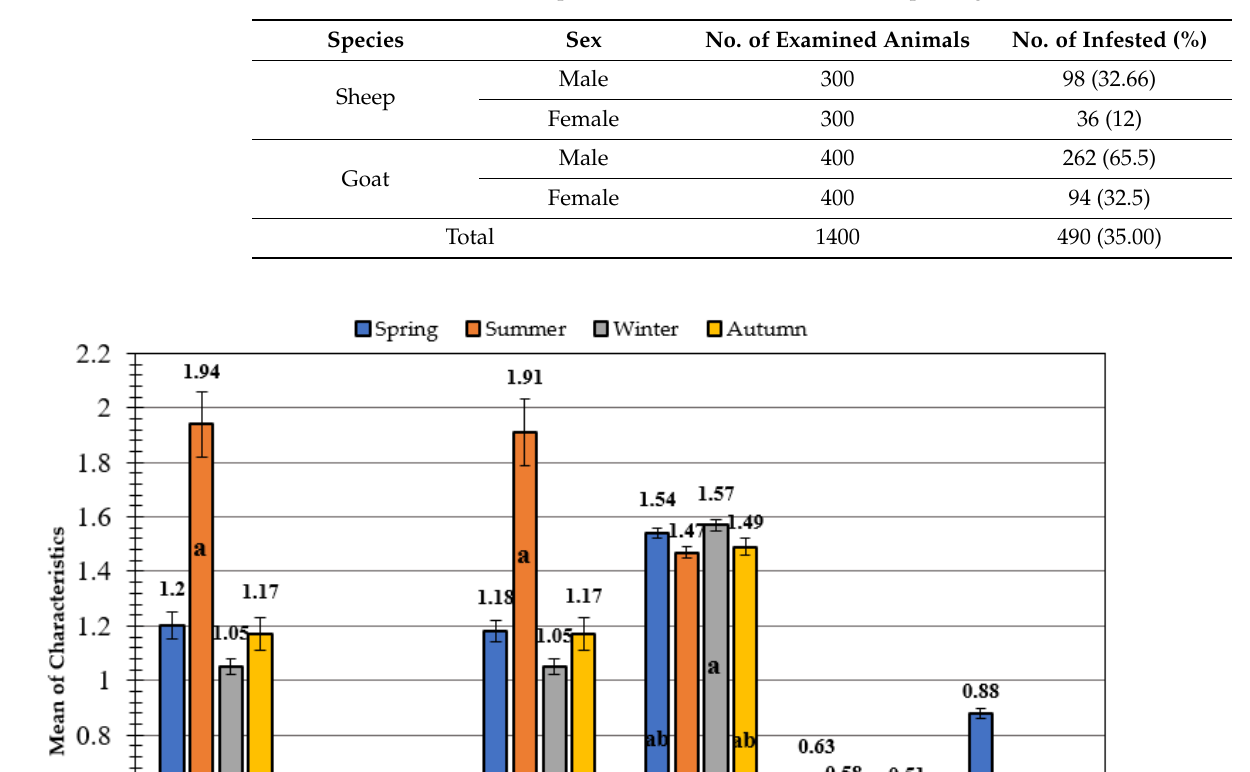
Table 3. Sex differences on the prevalence of Oestrus larvae in sheep and goats.